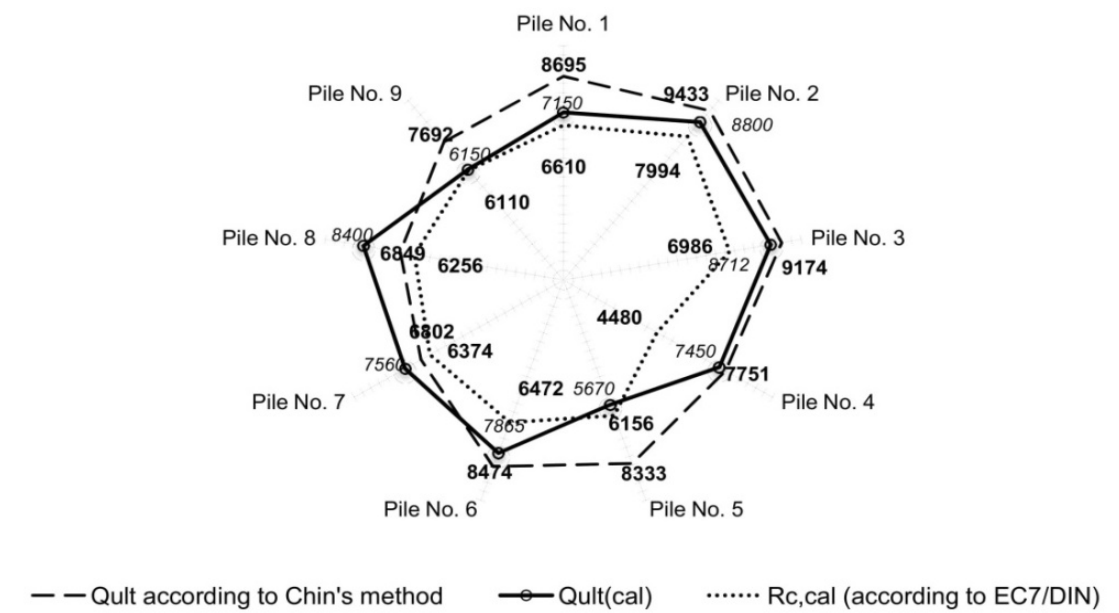
Figure 13: Values of calculated limit of load-bearing